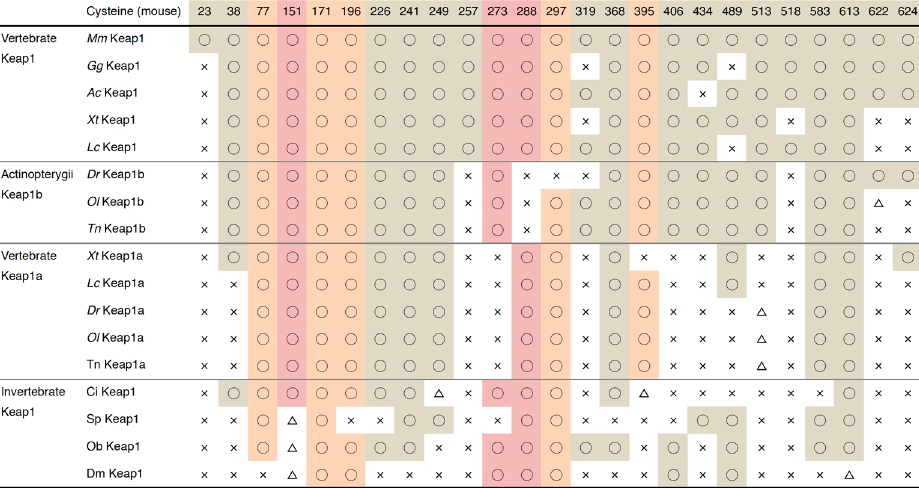
Figure 6. A summary of the cysteine residues of Keap1. The conservation of each cysteine is indicated as follows ○ : conserved; △ : not conserved but cysteine exists within three amino acids; ×: not conserved. Sensor cysteines are shaded in red, and cysteine residues conserved among Kelch family proteins in mice are shaded in orange.